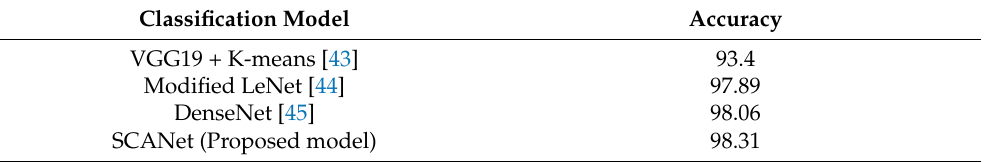
Table 5. Comparison of the classification results using corn leaf diseases dataset.